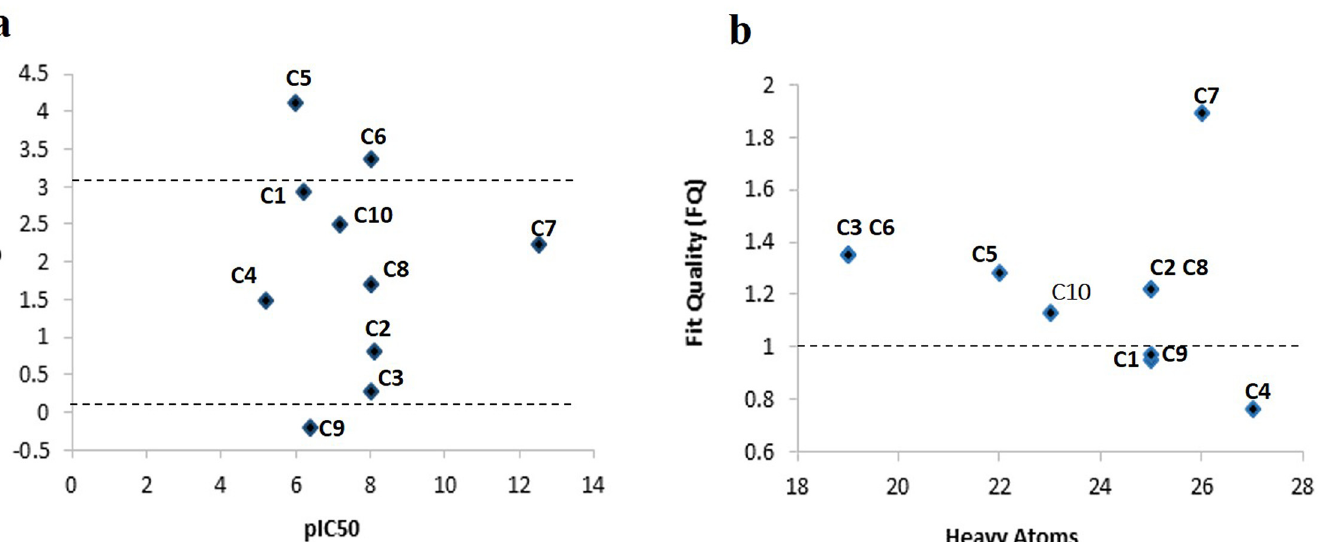
PHE210 (0.8-2Å) and LEU333 (1.5-2Å) residues (Fig 8A), while residues involved in inhibitor